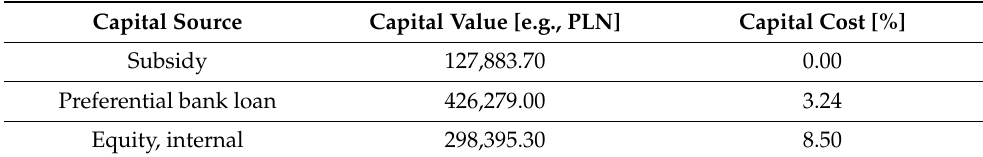
Table 15. List of available capitals and costs of their obtaining for financing a project. Source: designed by authors.